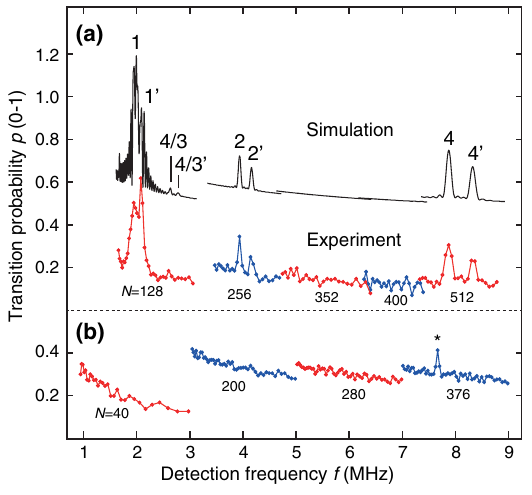
FIG. 4. (a) Spectrum recorded by a NV center with two weakly coupled 13 C nuclei, measured using an XY 8 sequence. Multiple harmonics are clearly observed. Colors represent different data sets. Coupling constants for the two 13 C are a ⊥ = 2 π ¼ 220 kHz and a 0 ⊥ = 2 π ¼ 180 kHz. The number of pulses N is given in the plot. The associated total evolution time is T ¼ N= ð 2 f Þ . Further parameters are ω 1 = 2 π ¼ 28 MHz and Δ z ¼ 1 . 5 MHz (because of the 15 N hyperfine splitting). (b) For comparison, the spectrum was recorded by a NV center with no 13 C nearby. The peak 400 nT. marked by * is due to an ensemble of 1 H with B rms ac ¼